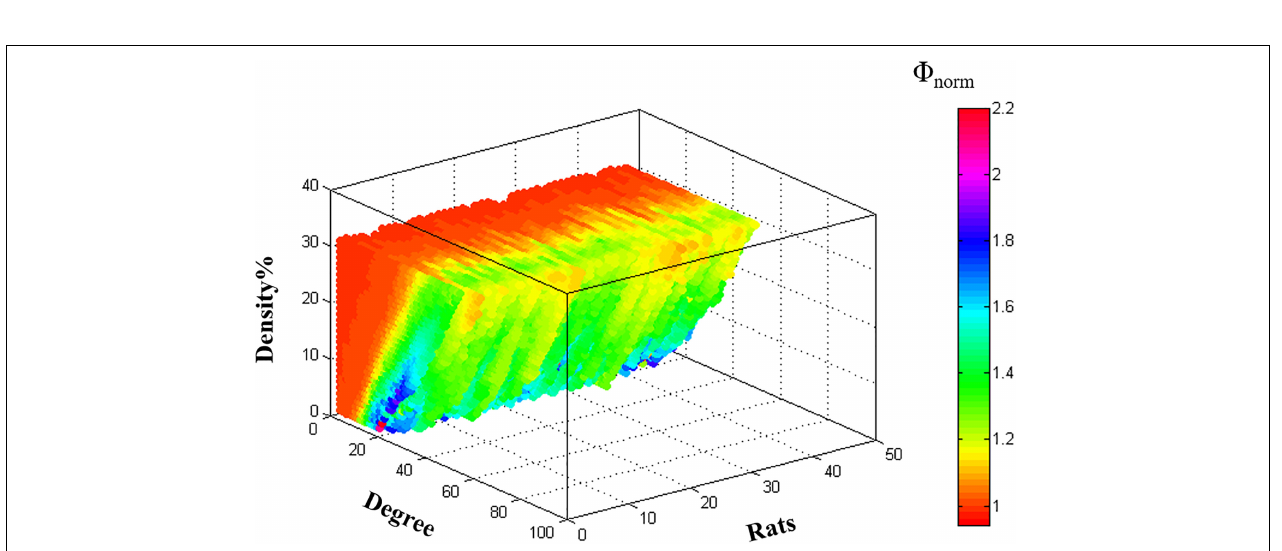
FIGURE 3 | The characteristic rich-club organization of individual metabolic networks in young rats and aged rats.